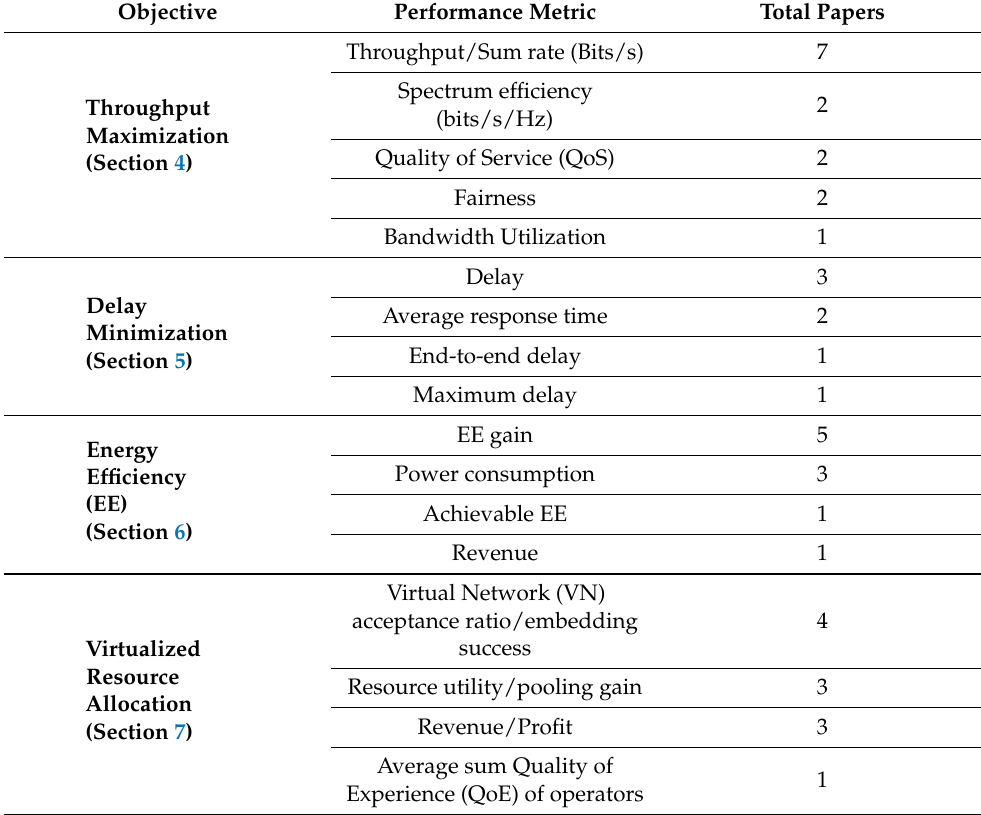
Figure 3. Distribution of optimization algorithms for converged optical and mmWave radio resource management. Table 1. Distribution of the main performance metrics depending on optimization